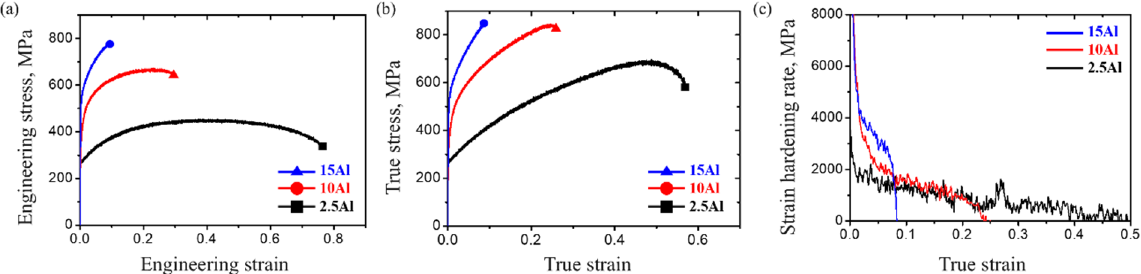
Figure 5. ( a ) Engineering and ( b ) true stress-strain curves of the present alloys. ( c ) Strain hardening rates (SHR) versus true strain of the present alloys.